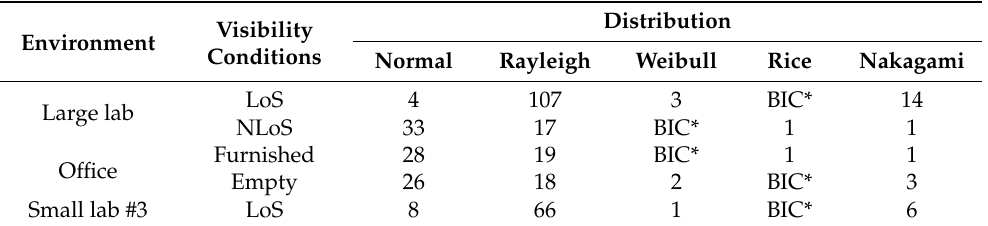
Table 3. ∆ BIC values at different measurement environments, 5.8 GHz